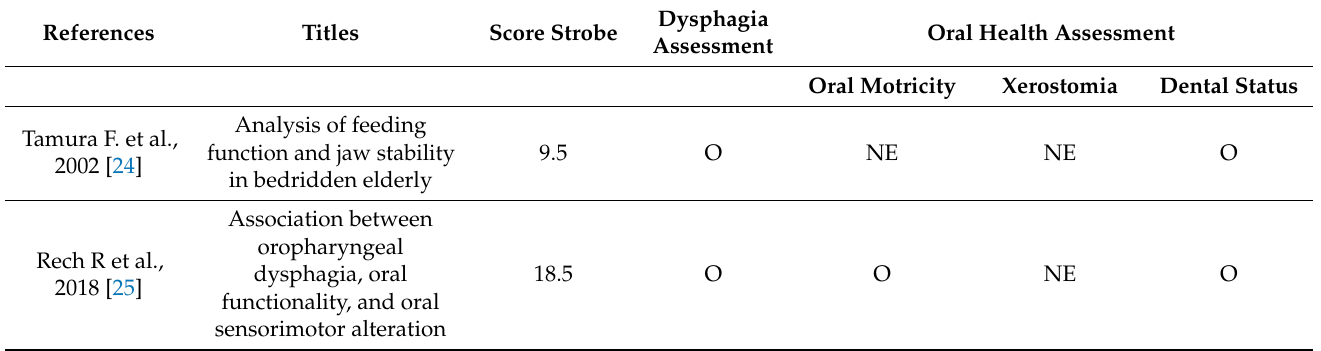
Table 1. Title, year of publication, STROBE score, methods of evaluation, and oral health